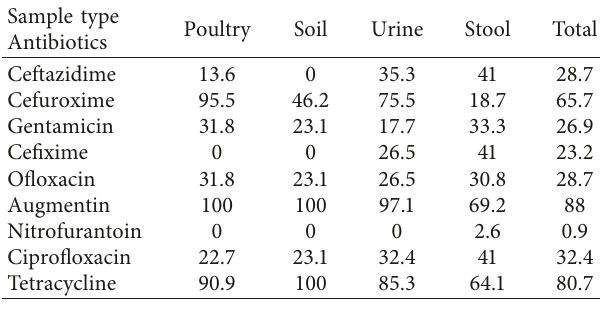
Table 2: Percentage occurrence of antibiotic resistance in Escherichia coli isolates.